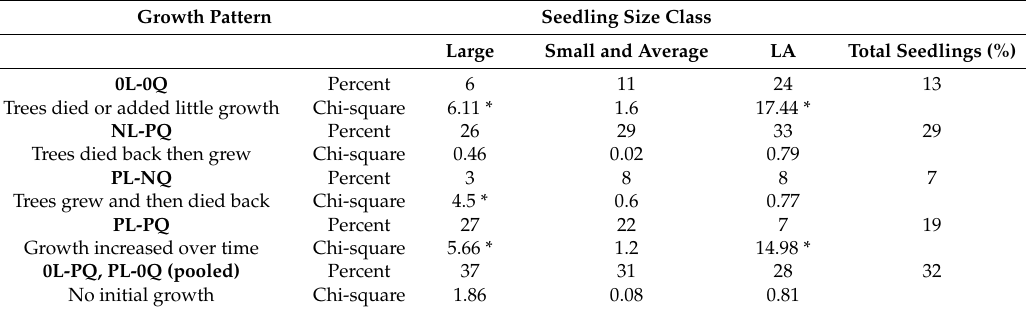
Asterisks (*) indicates the observed number within a cell differs significantly from